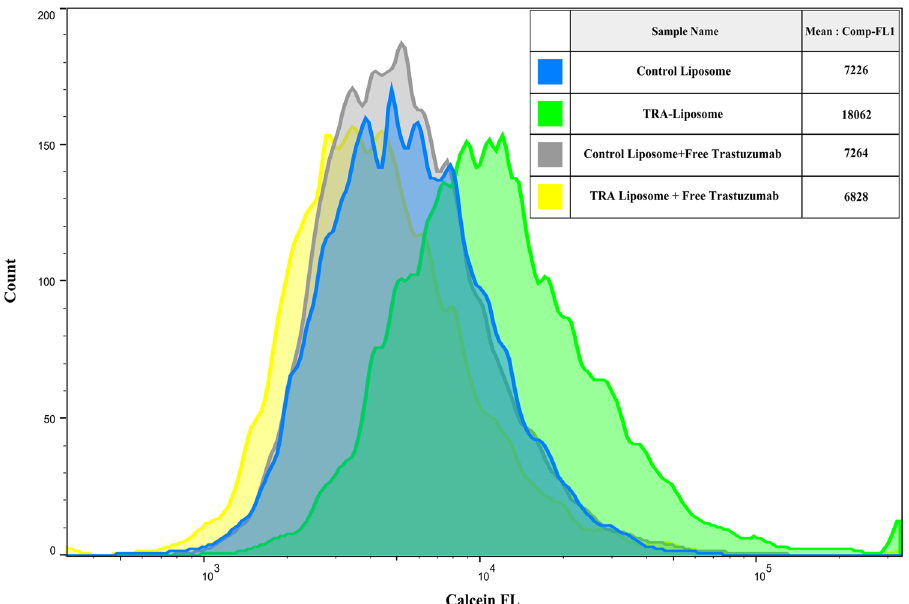
Figure 4. Flow cytometry analysis showing calcein fluorescence intensity inside SKBR3 cells incubated with the either the control or TRA-liposomes with or without prior incubation with free Trastuzumab (1 mg/ml). An average of 1 × 10 4 cells was analyzed from each sample with calcein fluorescence intensity showing on a four- decade log